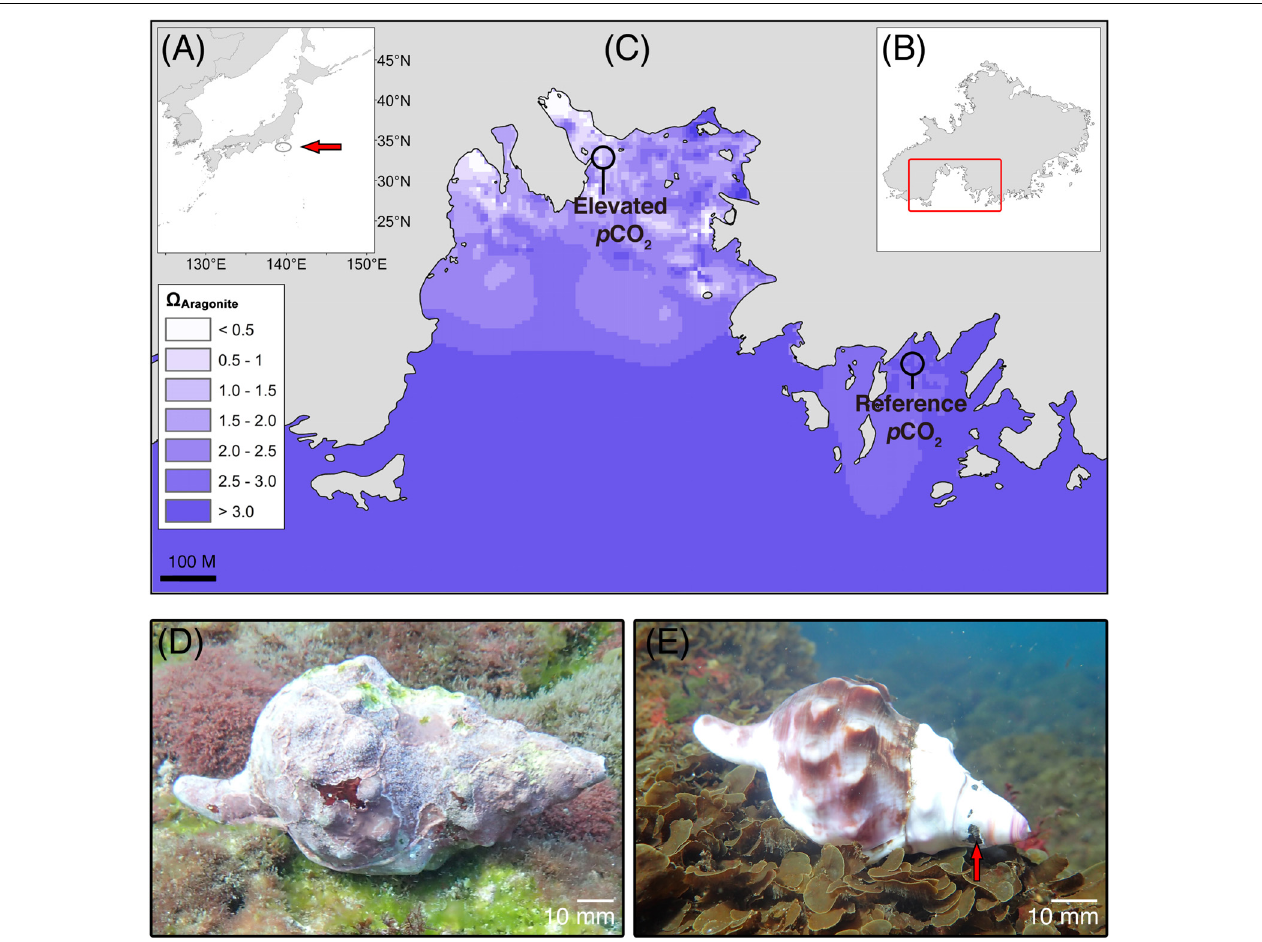
FIGURE 1 | Study area (Mikama Bay, Shikine-jima, Japan) for the collection of Charonia lampas . (A) Location within Japan (arrow), (B) location of Mikama Bay on Shikine-jima, and (C) aragonite saturation state ( (cid:127) Arag ) of the study site (modified from data in Agostini et al., 2018 using ArcGIS “spline with barriers” interpolation tool), with the collection areas for the “elevated p CO 2 ” individuals (near CO 2 seeps) and “reference p CO 2 ” individuals from an adjacent bay highlighted. Representative Charonia lampas at the reference site, pH T 8.14 (D) and at the elevated p CO 2 site, pH T 7.81 (E) . Note extensive coverage of encrusting organisms and intact apex region. At the elevated p CO 2 site shells had a smooth bare shell surface and severely eroded apex regions